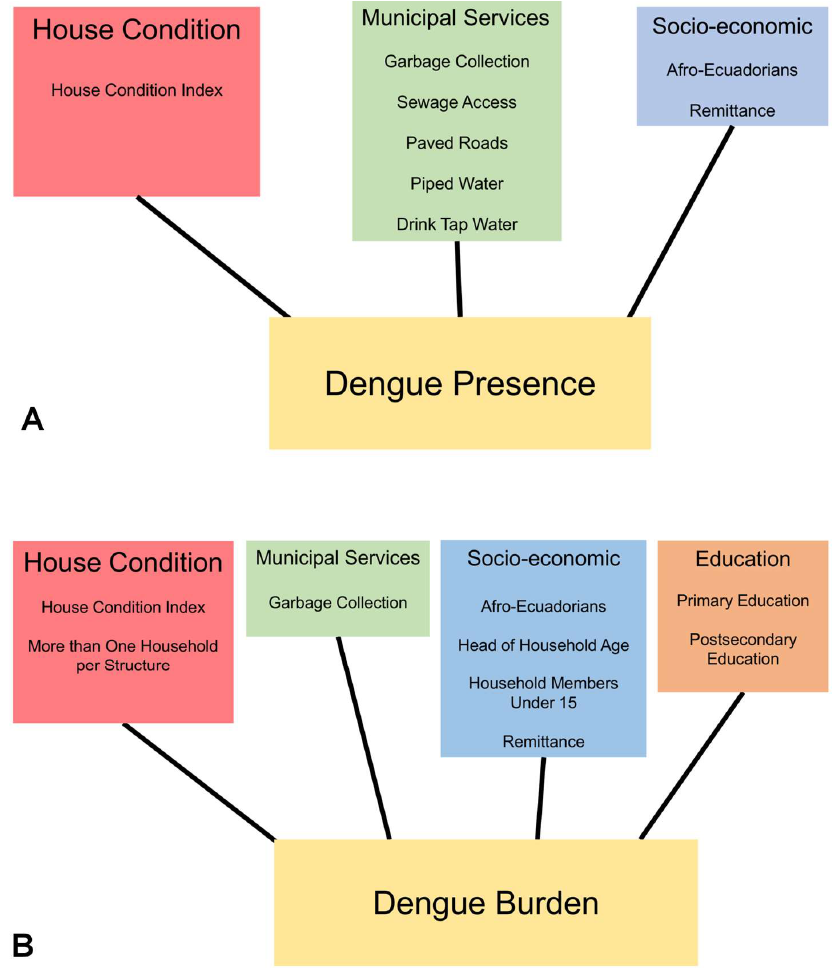
Figure 5. Conceptual diagrams highlighting the census variable suites that significantly affected dengue presence ( A ) and dengue burden ( B ) in Guayaquil, Ecuador during the 2012 outbreak.